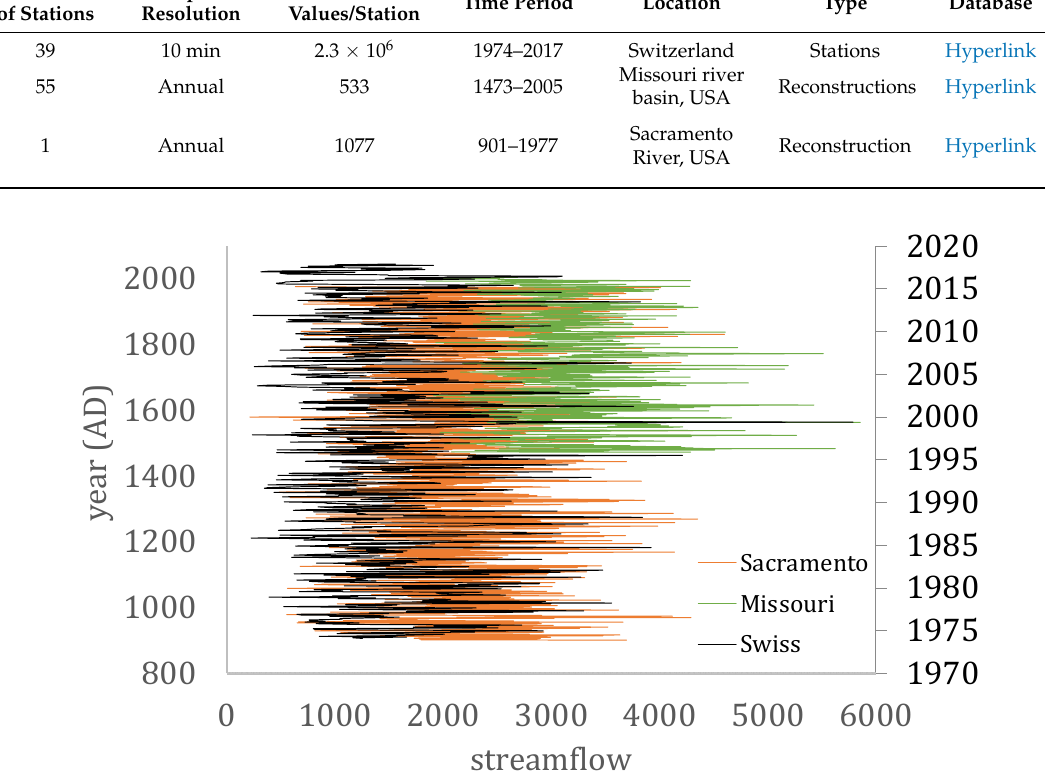
Figure 1. The reconstructed streamflow time series at Sacramento from 901 to 1977 (in 10 × hm 3 /year and of annual resolution), the reconstructed streamflow time series from the Missouri database from 1473 to 2005 (with ID 6278300, in 10 − 2 × hm 3 /year and of annual resolution) and the 6th streamflow recorded time series from the Swiss database ranging from 1974 to 2017 (in hm 3 /year and of aggregated monthly resolution).